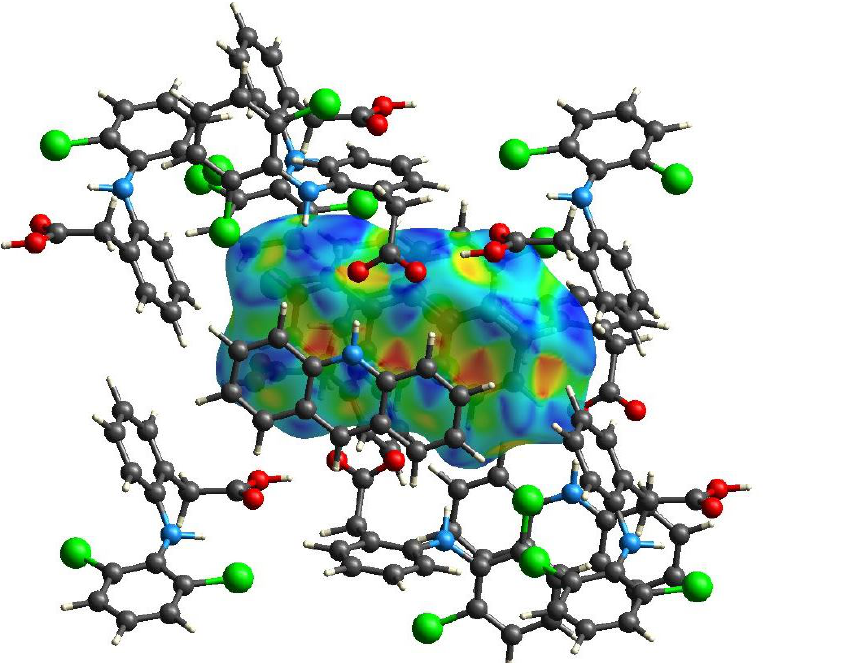
Figure 4. Shape index plotted on the Hirshfeld surface for the 1:2 single-crystal structure.